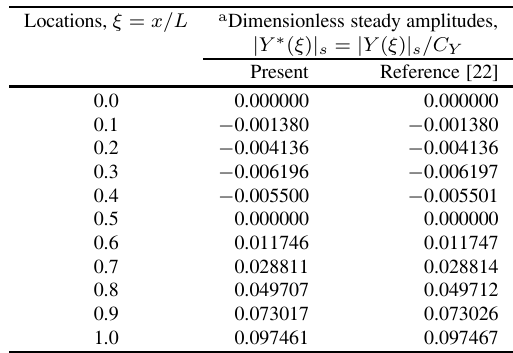
Table 2 The dimensionless vibration amplitudes at different posi- tions of the cantilever beam (with “zero” initial conditions) having an intermediate pinned-support and subjected to a concentrated harmonic force at free end (cf. Fig.